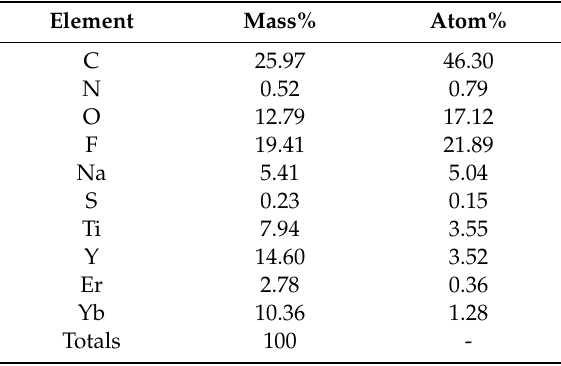
FTIR spectroscopy results for N-TiO 2 /NaYF 4 :Yb,Er and CNS-TiO 2 /NaYF 4 :Yb,Er are shown in